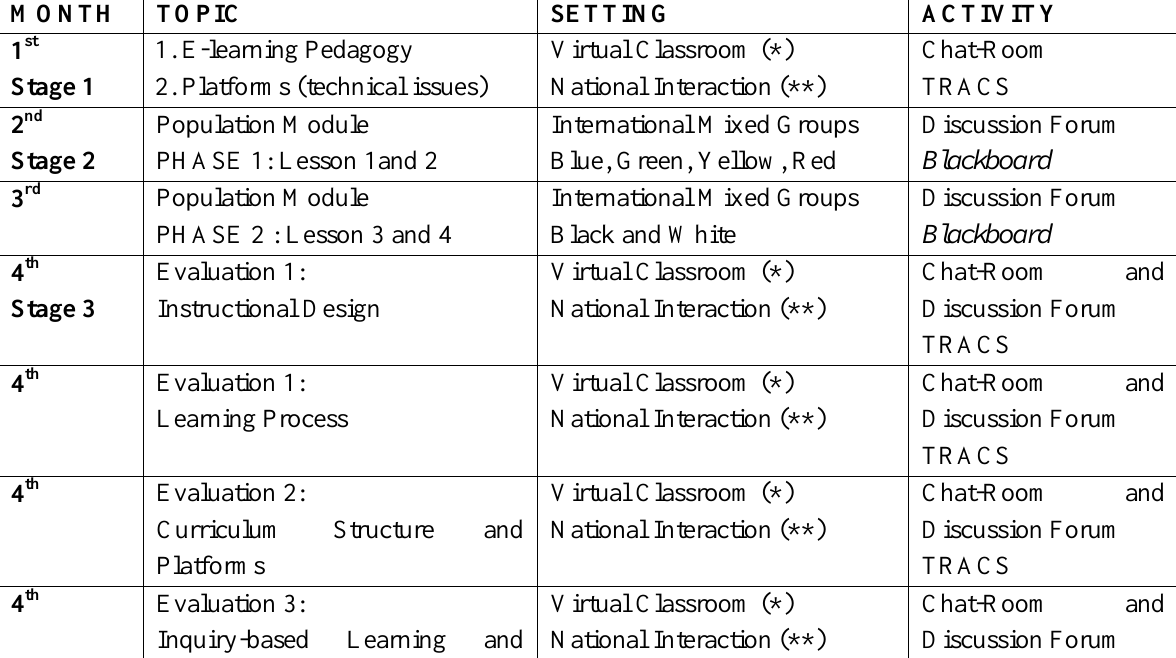
Three Stages of the Online Interaction Program MONTH TOPIC SETTING